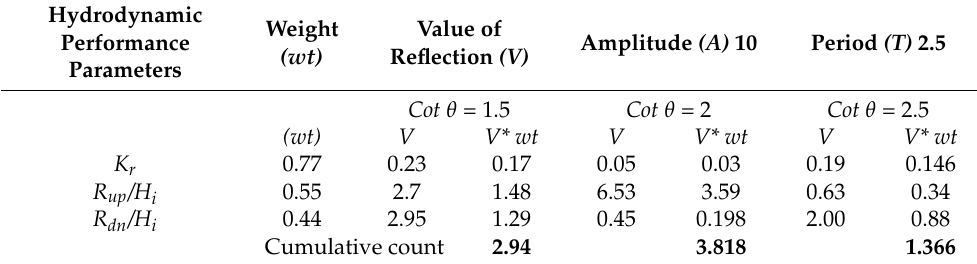
Table 8. Sample hydrodynamic performance parameters for three slopes and similar wave conditions for